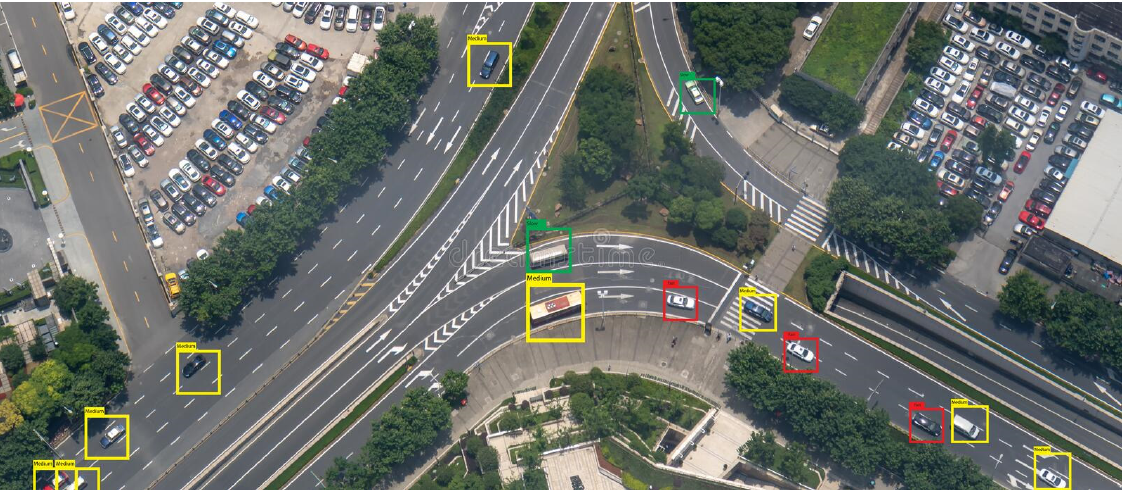
Figure 2. Artificial intelligence and machine learning for the internet of things; speed automobile object detection.